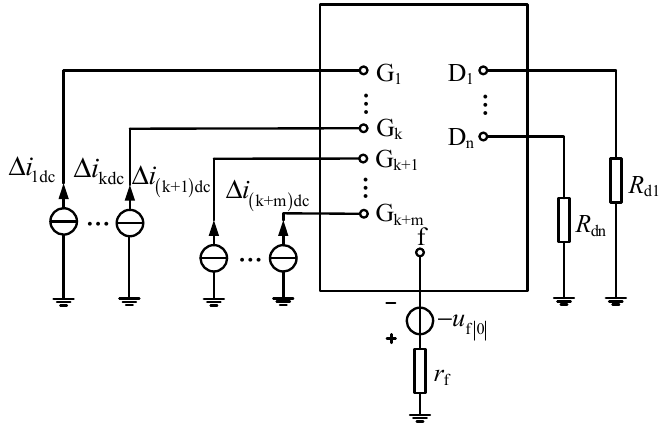
Figure 11. Fault component network of DC components during a fault.